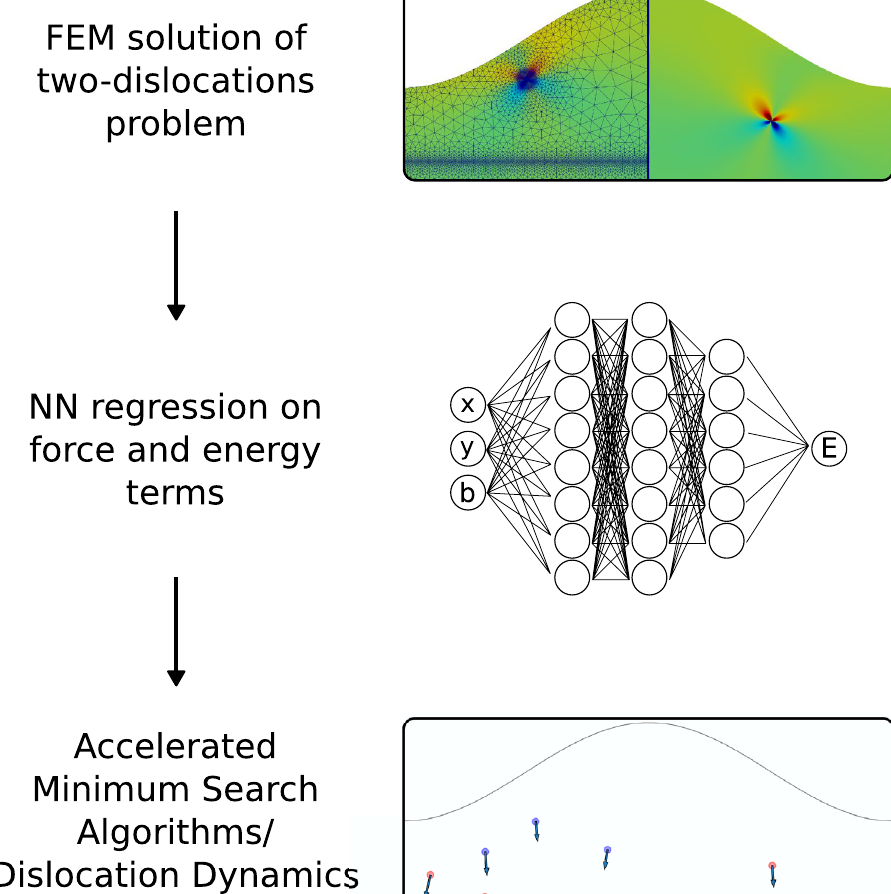
Figure 1. Sketch of the proposed method. A TS is constructed exploiting the interaction decomposition by numerically solving two-dislocation problems. Neural Networks are used to build predictive models of energies and forces of dislocation configurations. These are then used to search for low energy configurations or dislocation dynamics simulations orders of magnitude faster than by FE bruteforce